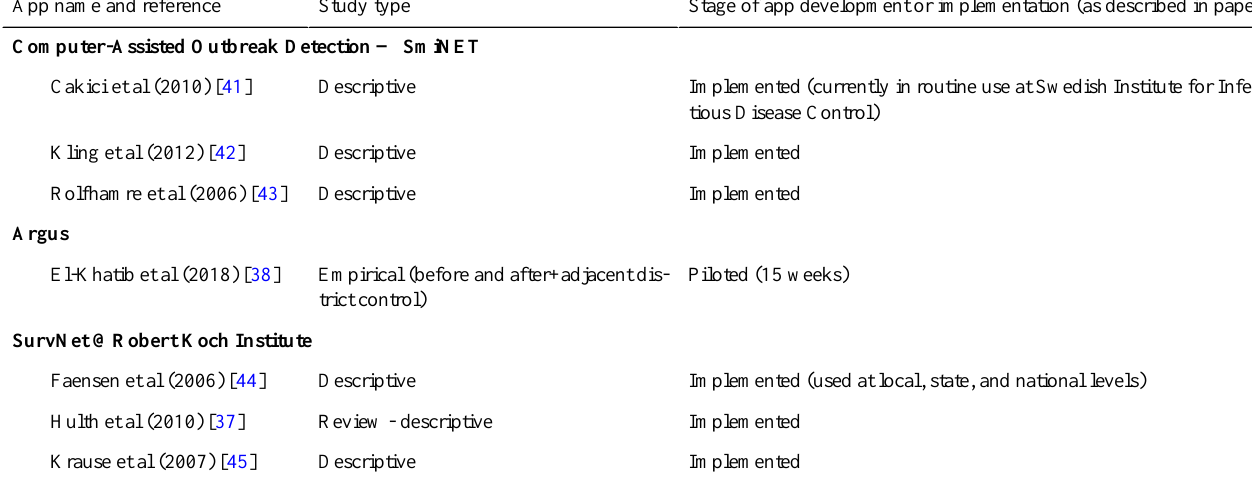
Table 1. Summary of included papers. Computer-Assisted Outbreak Detection — SmiNET